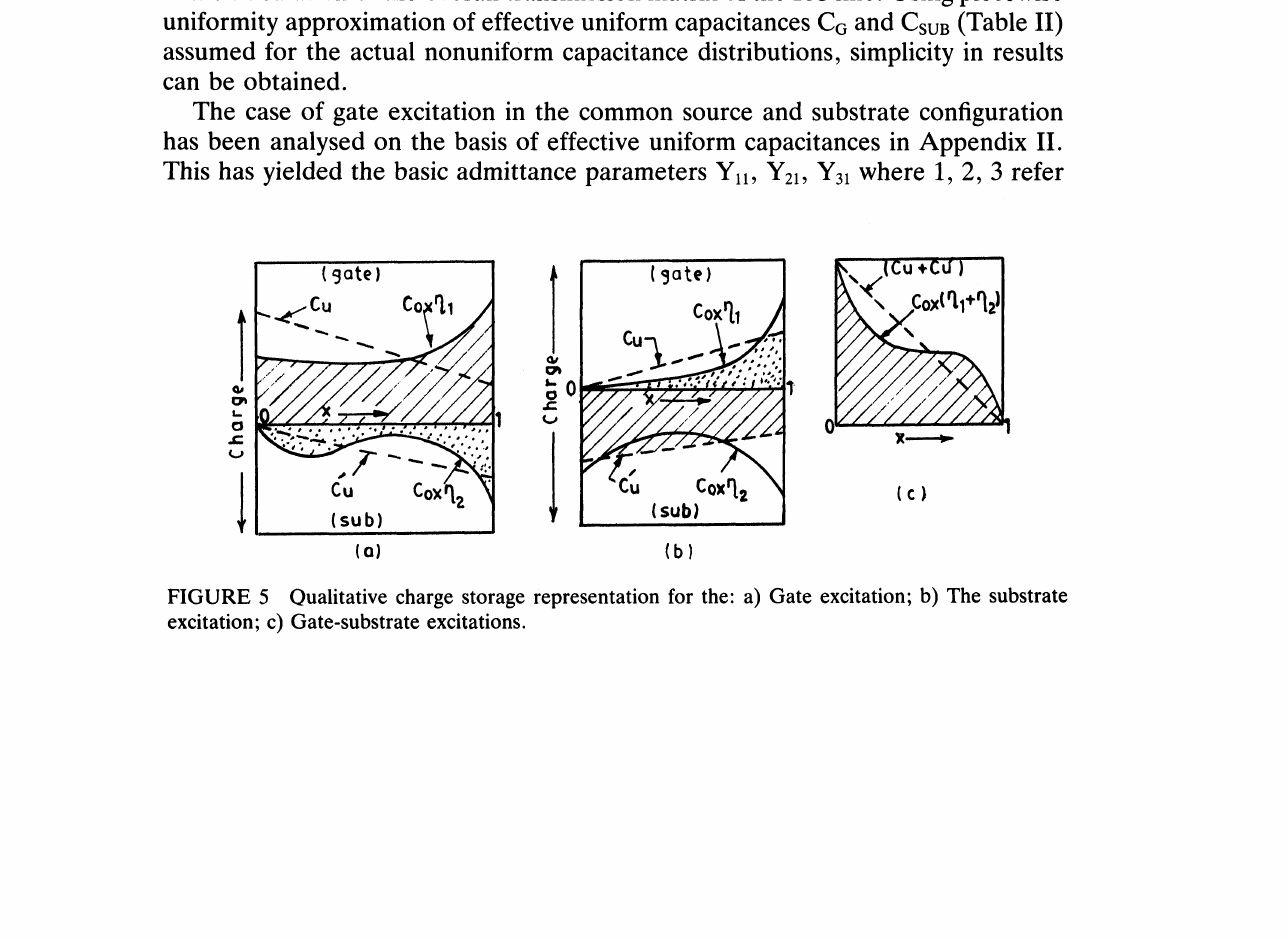
FIGURE 5 Qualitative charge storage representation for the: a) Gate excitation; b) The substrate excitation; c) Gate-substrate